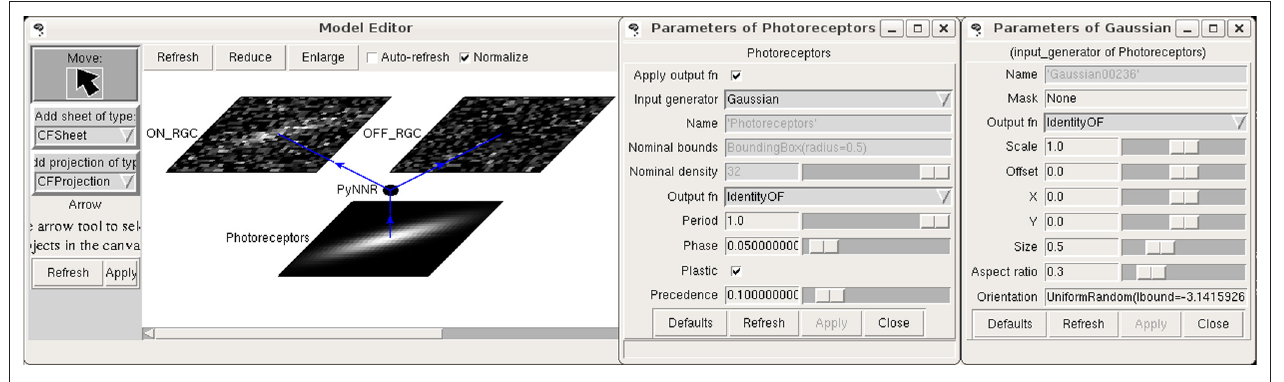
FIGURE 4 | Example architecture. This fi gure shows the simulation from Figure 3 running in Topographica. On the input sheet is a 2D Gaussian pattern generated by Topographica and presented to the underlying spiking network,